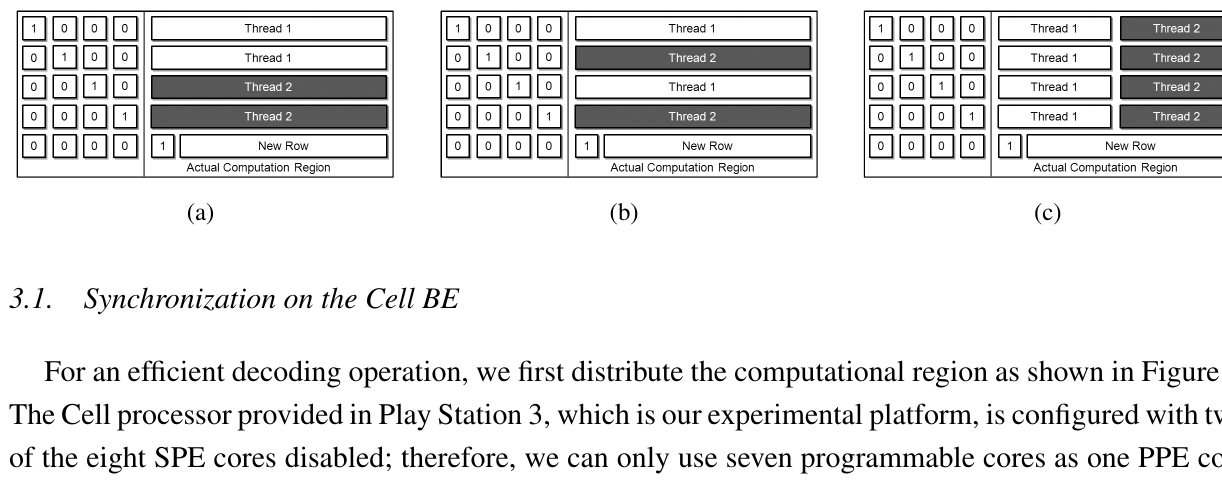
Figure 6. Parallelization algorithms of network coding on Homogeneous processor; ( a ) HP; ( b ) RRP; and ( c )